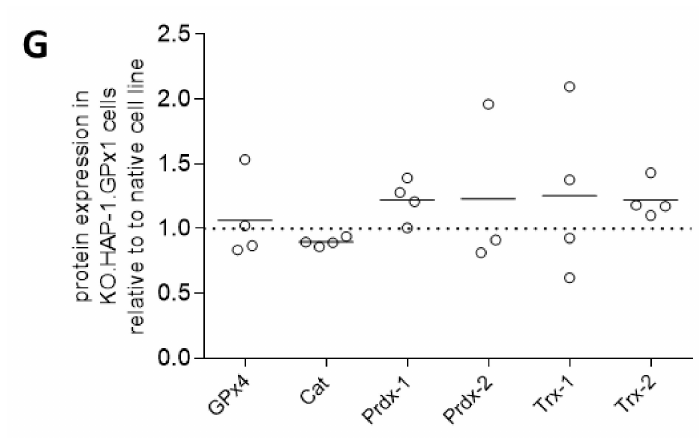
Figure 1. ( A ): Representative western blots of protein expression in parental HAP-1 cells and its GPx1 knockout variant KO.HAP-1.GPx1 for glutathione peroxidase-1 and -4 (GPx1, GPx4), catalase (Cat), peroxiredoxin-1 and -2 (Prdx1, Prdx2) and thioredoxin-1 and -2 (Trx1, Trx2) while total protein normalization was used as a loading control; ( B ): Microscopic images of HAP-1 and KO.HAP-1.GPx1 cells; ( C ): Cell sizes and viability in HAP-1 and knockout cells in suspension as measured by